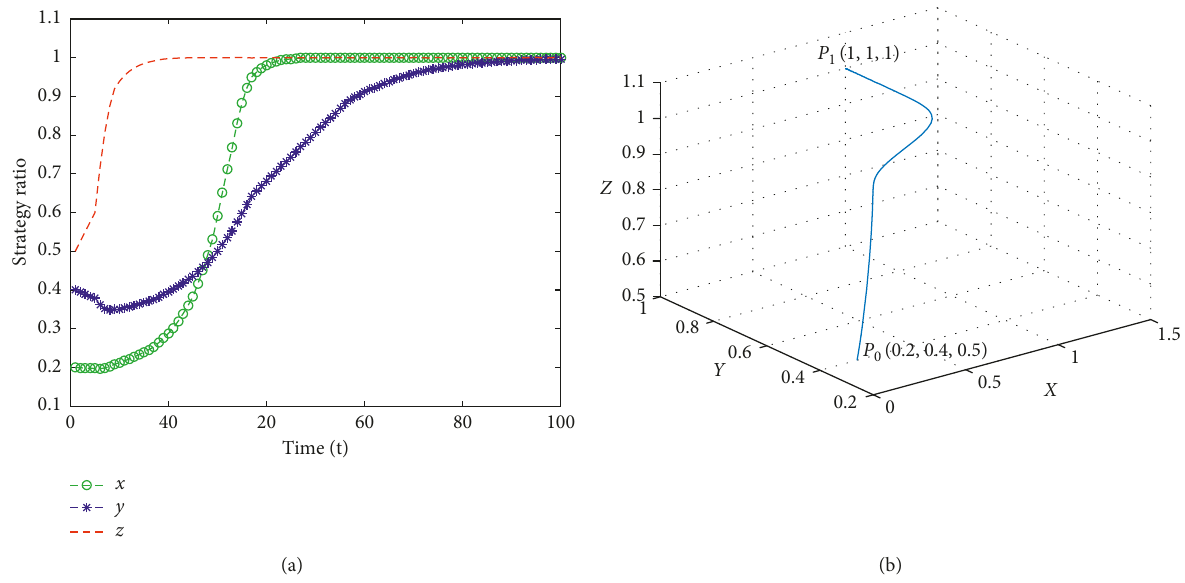
Figure 6: The dynamic evolution of the tripartite game model when x � 0 . 2 ,y � 0 . 4 , and z � 0 . 5. (a) Time evolutions of x , y , and z . (b) Time evolution of ( x , y , z ).